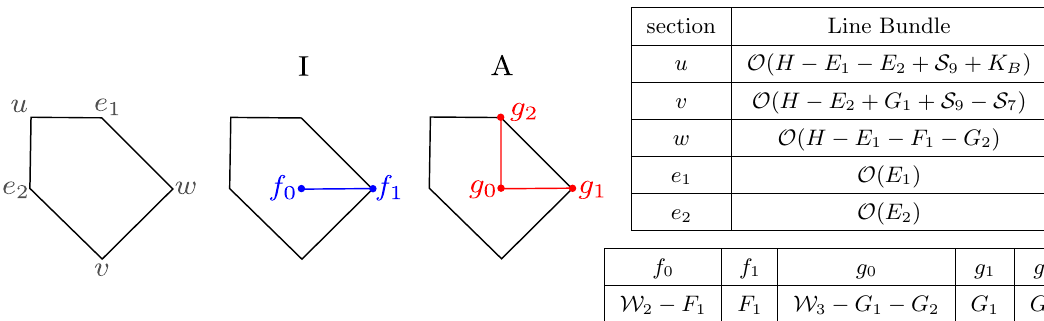
Figure 5 . The tops I and A used to engineer the non Abelian gauge symmetry SU(3) (cid:2) SU(2) over F 5 [49, 50]. The table contains the divisor classes of the P F coordinates. Note that some divisor classes for the ambient space coordinates get modi(cid:12)ed in the presence of the